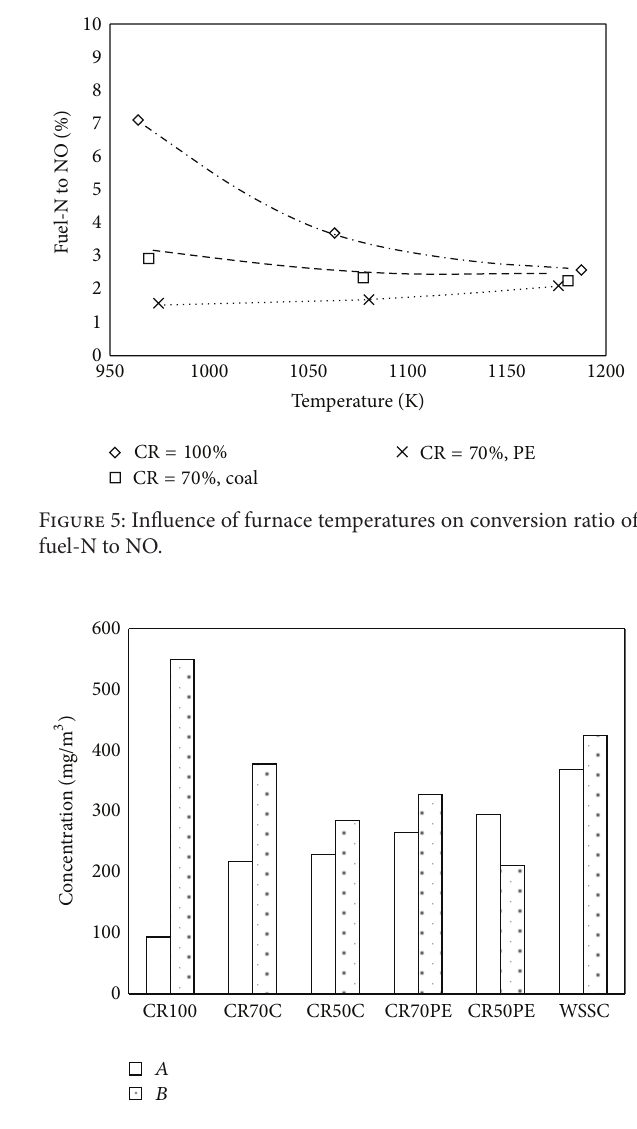
Figure 6: Influence of cofiring rates on N 2 O emission. A: N 2 O; B: